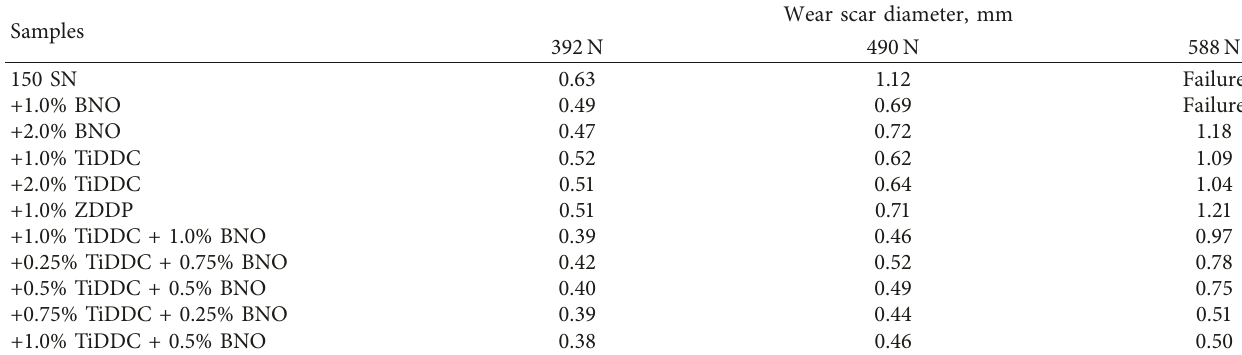
Table 1: Antiwear properties of TiDDC and BNO.